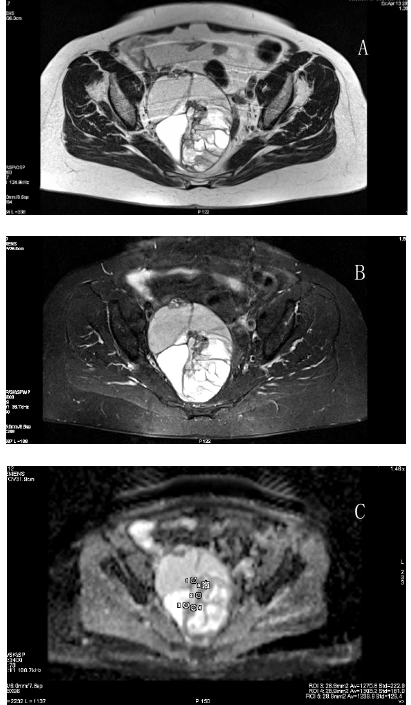
Figure 1. Images from 77 year-old women with low-grade serous ovarian cancer. ( A ): A large primary ovarian multicystic tumor on T2-weighted; ( B ): on T2 STIR; ( C ): Diffusion-ADC maps. Small ROI is placed on a region appearing to be the most enhancing solid part of the tumor.